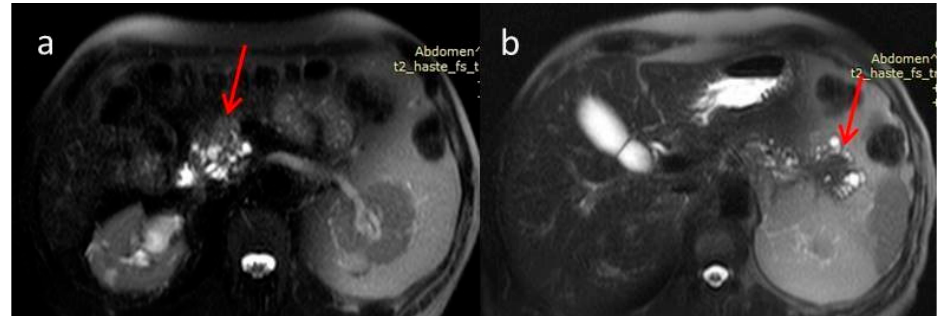
Figure 3. Magnetic resonance imaging T2-weighted image (MRI T2WI). The masses of the head ( a ) and tail ( b ) appear with low signal intensity (red arrows). Dilatation of the main duct is demonstrated with multiple dilated side branches. The overlying pancreatic parenchyma is thinned.